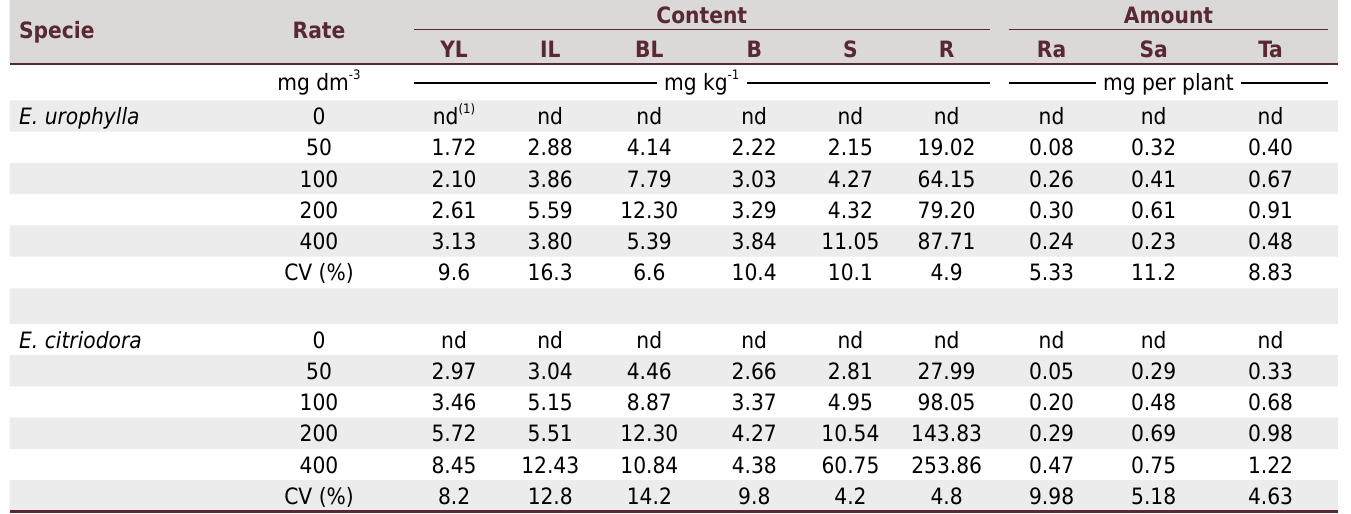
Table 2. Contents of arsenic in young leaves (YL), intermediate leaves (IL), baseline leaves (BL), branches (B), stem (S) and roots (R) and arsenic amounts in the roots (Ra), shoot (Sa), and whole (Ta) plants of E. urophylla and E. citriodora, according to the arsenic rates applied to the soil